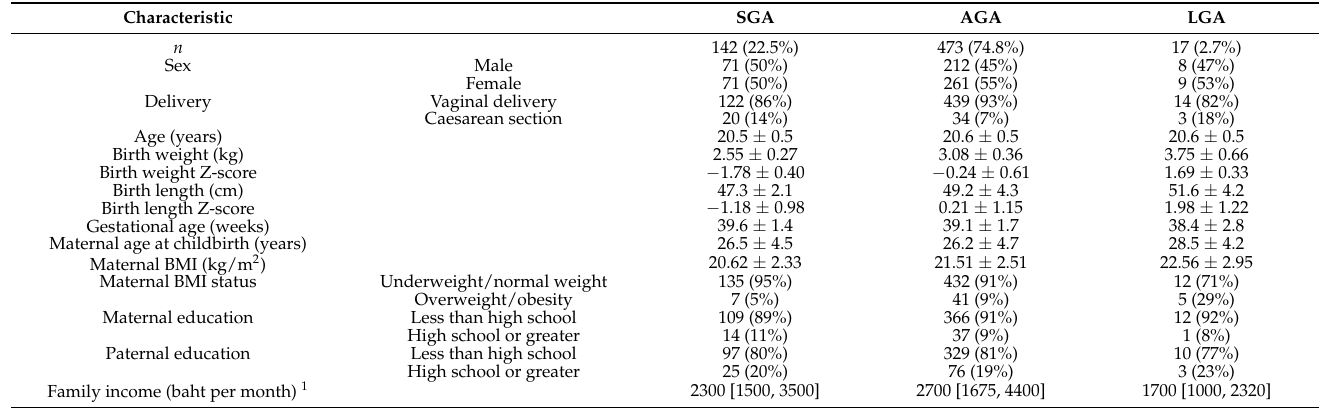
Table 1. Demographic and birth characteristics of our study population stratified by birth weight status.